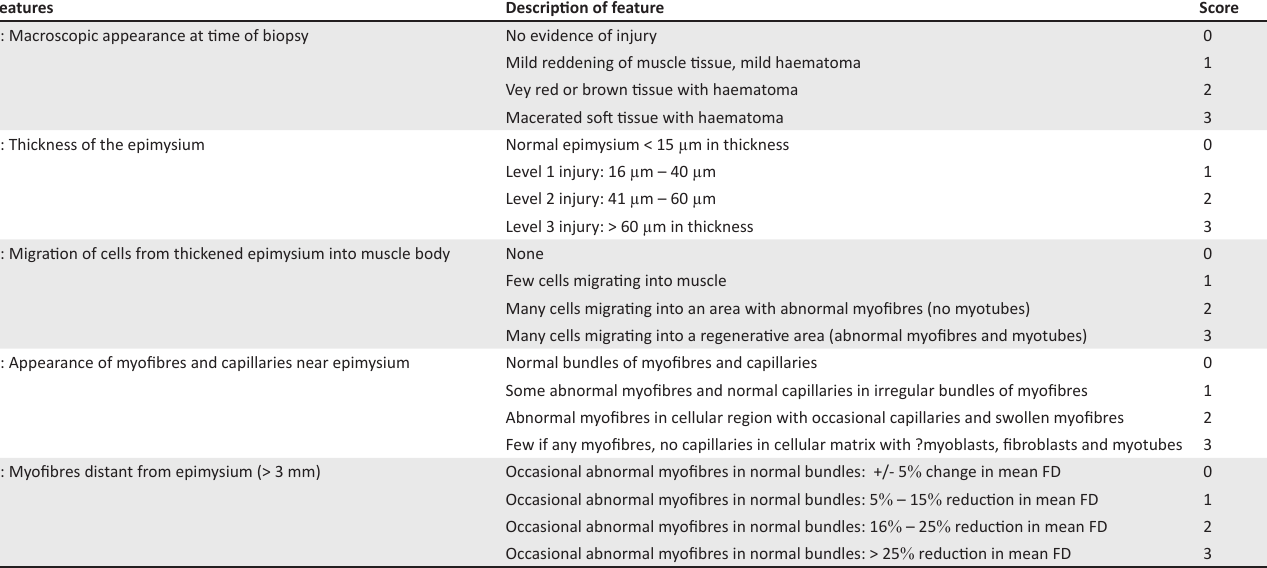
TABLE 3: Factors comprising the morphological index. Features